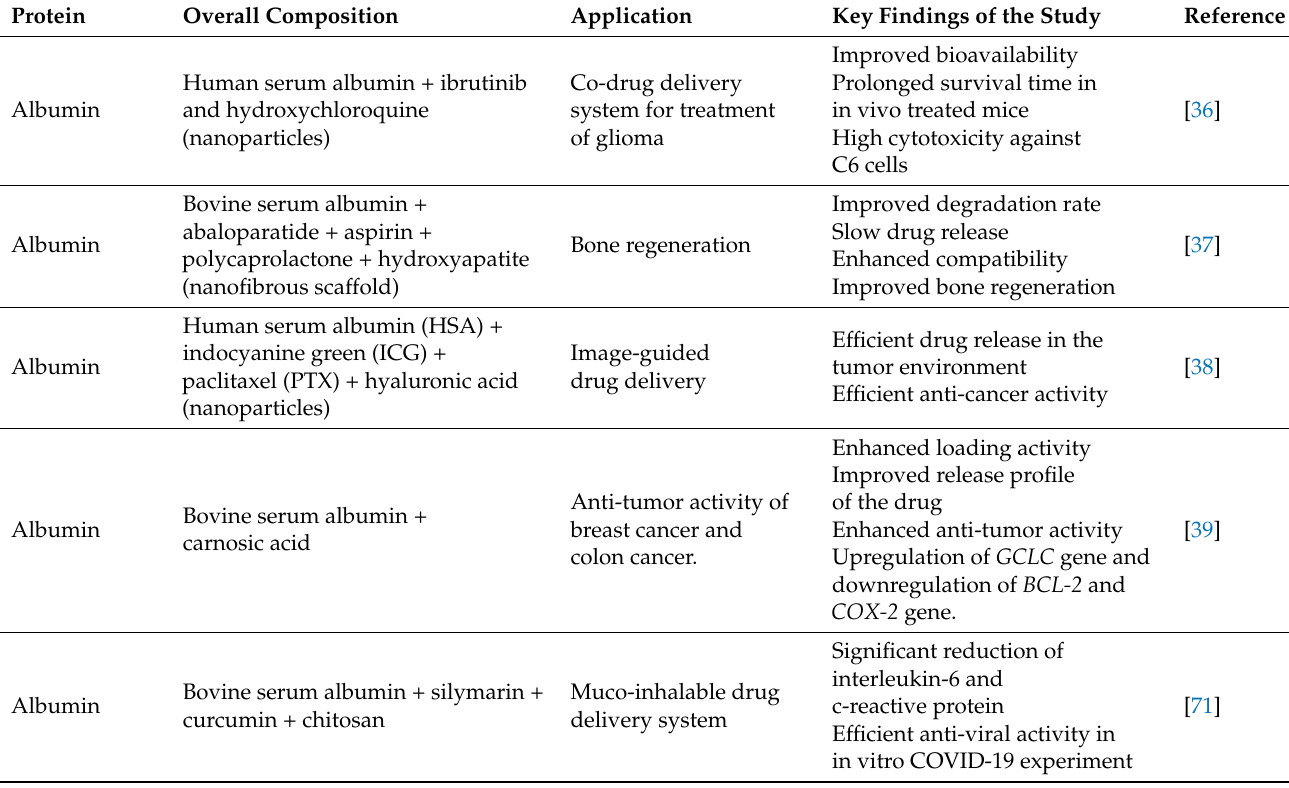
Table 2. Summary of protein-based biopolymeric nanoparticles. Application Key Findings of the